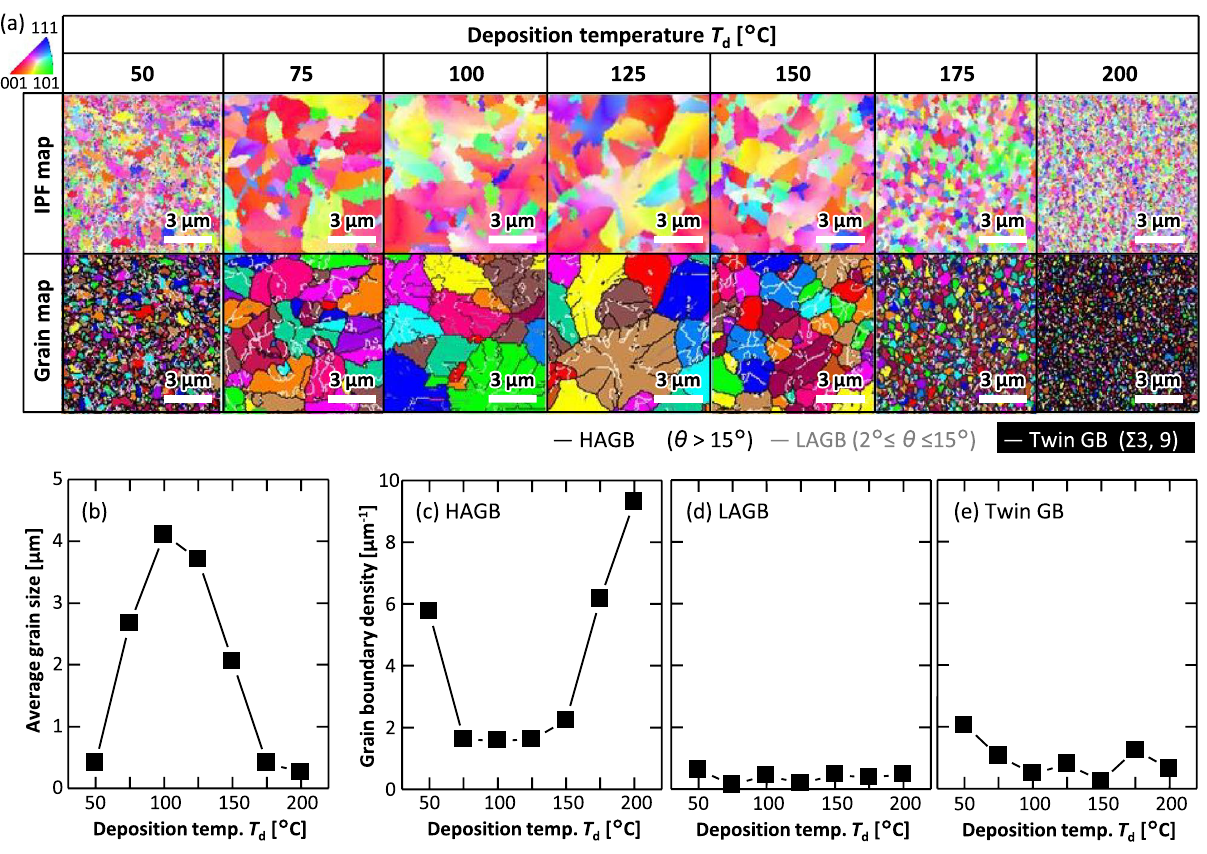
Figure 1. EBSD analysis of the Ge layers. ( a ) IPF and grain maps of the Ge layers as a matrix of T d . The colors in the IPF maps indicate crystal orientation, following the color key provided. ( b ) Average grain size as a function of T d . Grain boundary density as a function of T d of ( c ) HAGBs, ( d ) LAGBs, and ( e ) twin GBs.